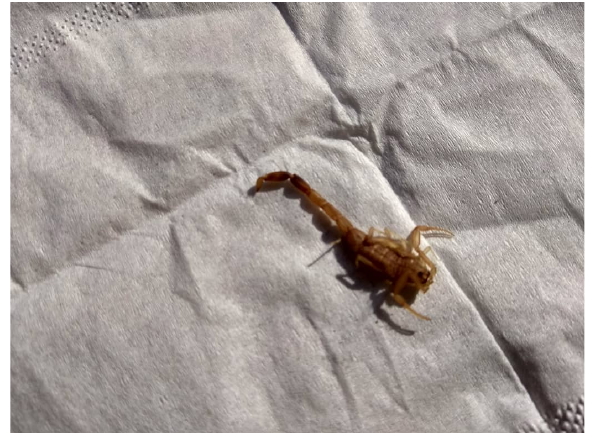
Figure 1. The dorsal surface of Compsobuthus matthiesseni.